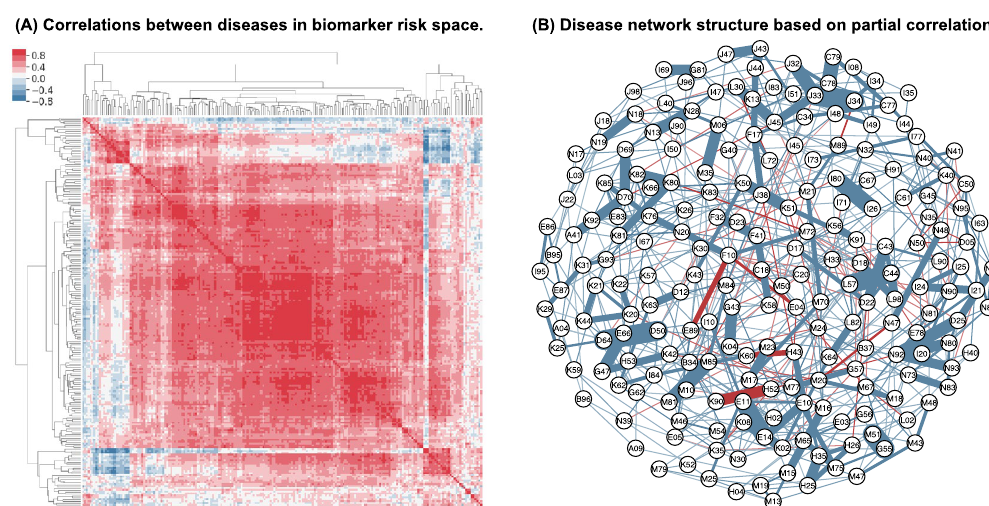
Figure 3. Biomarker-disease similarity. ( a ) Hierarchically clustered heatmap of correlation between biomarker- risk profiles across most common diseases in UK Biobank. Diseases show modality in biomarker profiles. ( b ) A partial correlation network of diseases. Nodes represent diseases, and edges represent the strength of biomarker associations between each pair of diseases given all other diseases, where blue is a positive association, and red is a negative association. Only edges with abs (strength) > 0.1 are